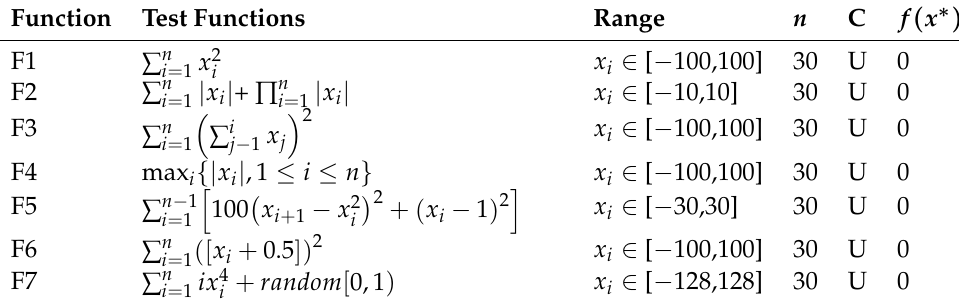
Table 2. The characteristics of unimodal benchmark